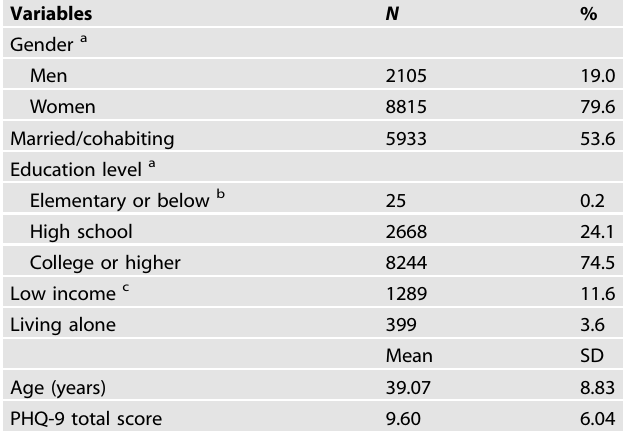
Table 1. Socio-demographic characteristics of the study population ( N = 11 072).